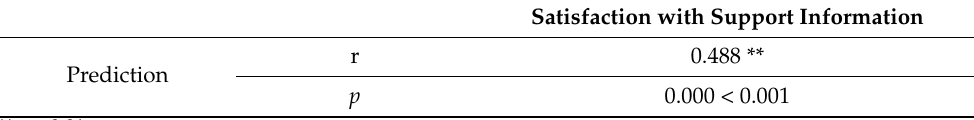
Table 4. The results of the analysis of Correlation.